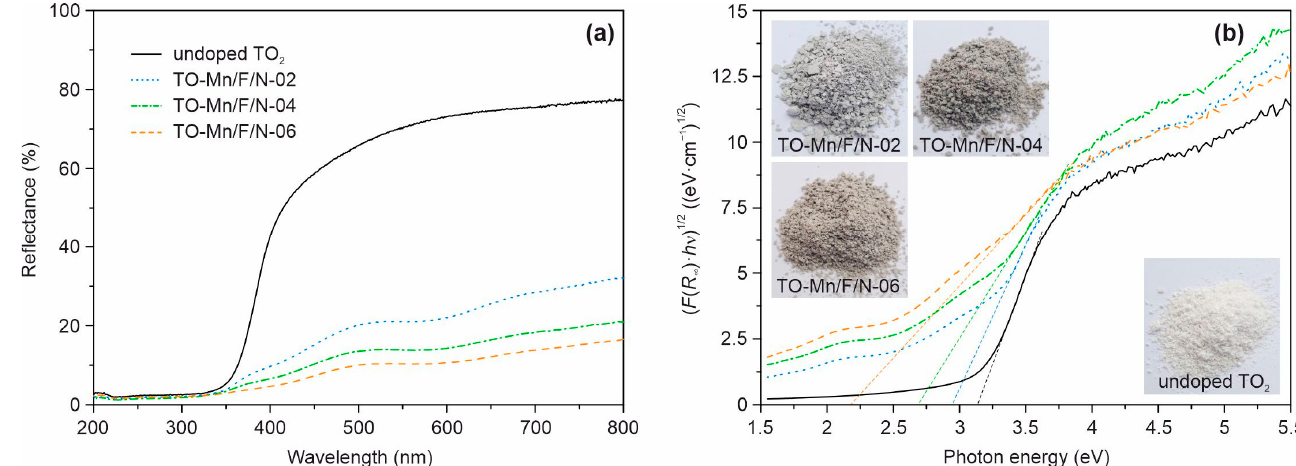
Figure 6. ( а ) UV-Vis di ff use re fl ectance spectra and ( b ) corresponding ( F ( R ∞ )· h ν ) 1/2 vs. h ν plots of unmodi fi ed TiO 2 , TO-Mn/F/N-02, TO-Mn/F/N-04, and TO-Mn/F/N-06 samples. The insets show photos of the analyzed powder products.